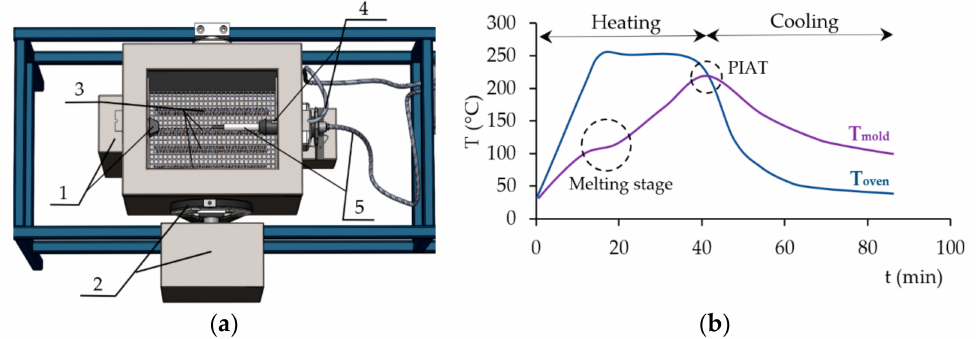
Figure 2. ( a ) A description of rotomolding machine 1—first stepper motor, 2—a belt drive with second stepper motor, 3—heaters, 4—temperature sensor in the oven, 5—temperature sensor in the mold; ( b ) typical curve plotted during the